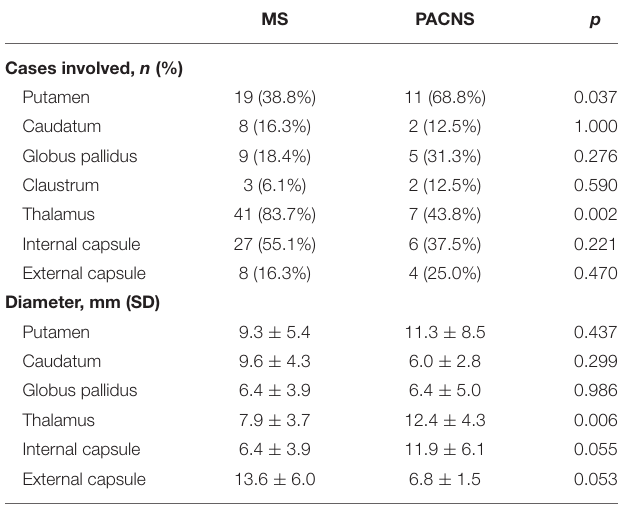
TABLE 2 | Comparison of basal ganglia/thalamus lesions between multiple sclerosis (MS) and primary angiitis of central nervous system